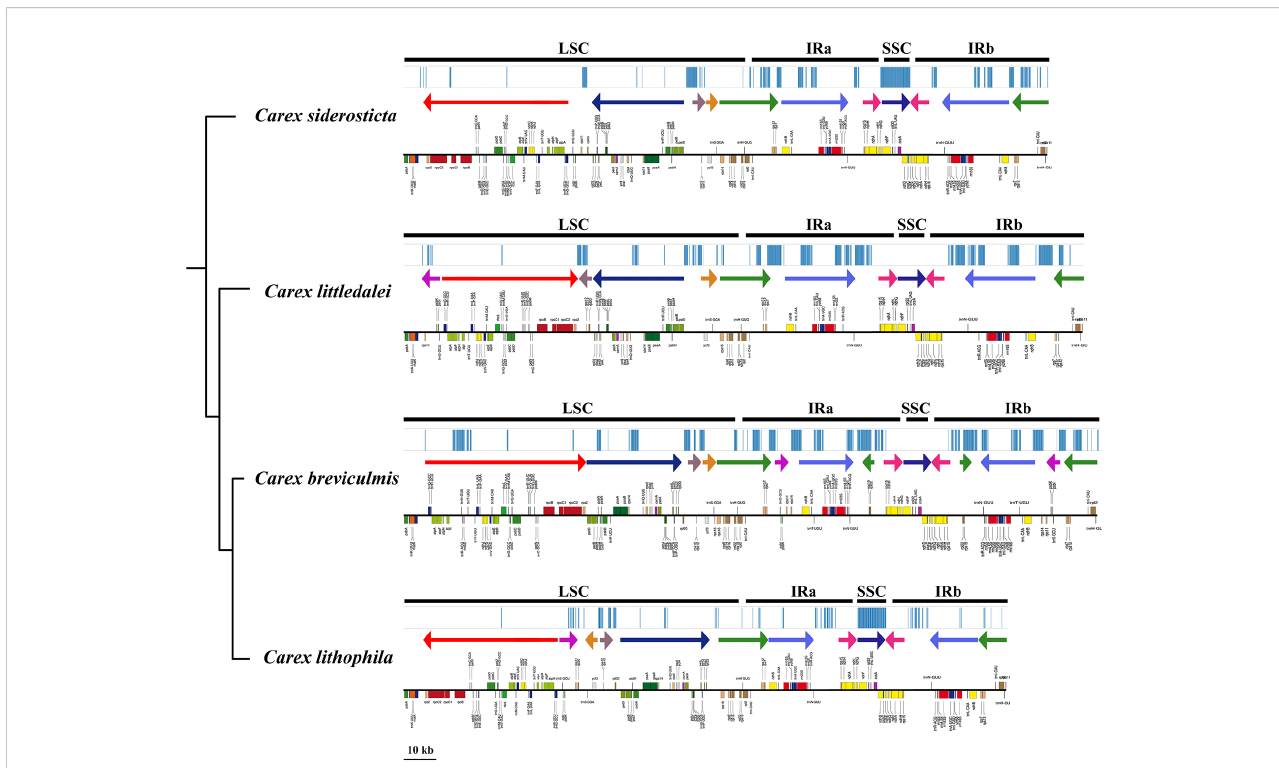
FIGURE 6 Comparative analysis of differences in chloroplast genomes of four Carex species. Bayesian consensus trees based on PCGs are placed on the left. The upper part of the image of each species shows the location of repeats (> 60 bp) in the chloroplast genome; the middle part shows the syntenic regions (arrows) and their directions, arrows of the same color represent syntenic regions between the different species; the lower part shows the map of the chloroplast genome drawn with OGDRAW